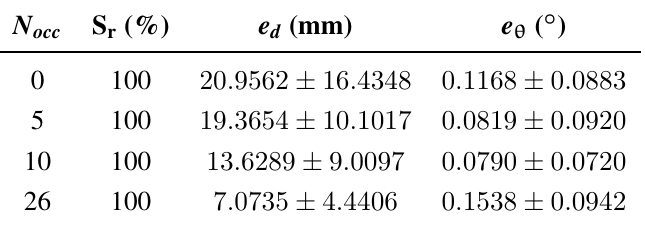
Figure 11. Occlusions originated by small unmodeled obstacles. Laser readings in purple. Robot’s location (100 , 100 , 0) in the blue square. Number of unmodeled obstacles, from = 5 ) ( right (top) ), two (10) left to right and top to bottom: zero ( left (top) ), one ( N occ ( left (bottom) ), three (26) ( right (bottom) ). Unmodeled obstacles in green. Table 7. KL-based DE-MC GL with different unmodeled obstacles. Robot’s location: (100, 100, 0). Errors are the mean ± standard deviation. Sensor noise: 1%